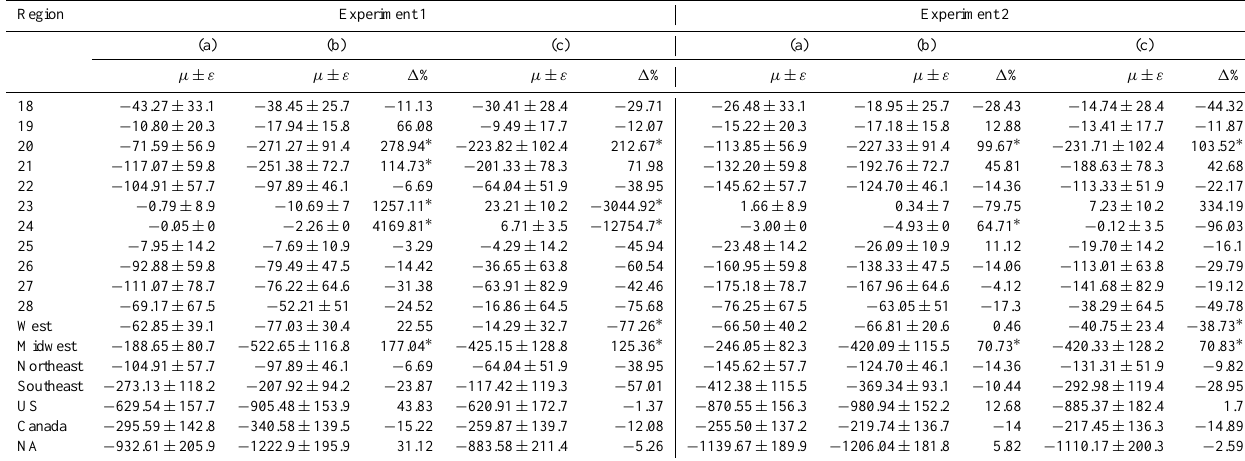
Table 4. Mean inverted CO 2 flux ( µ) , error ( ε) in TgCyr − 1 ,and the percentage change ( (cid:49) %) for global regions from 2002 to